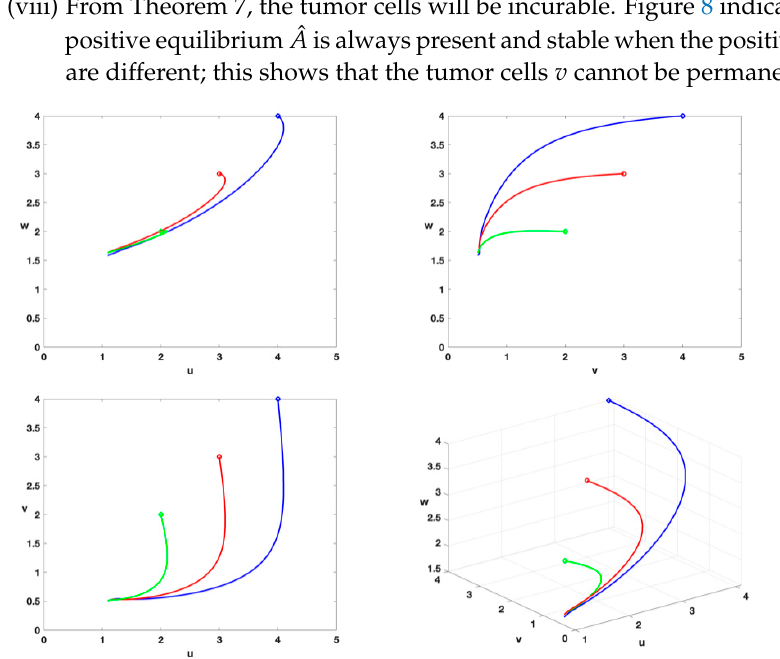
(viii) From Theorem 7, the tumor cells will be incurable. Figure 8 indicates that the unique Figure 7. Time series ( a ) and phase diagram ( b ) of equilibrium point with